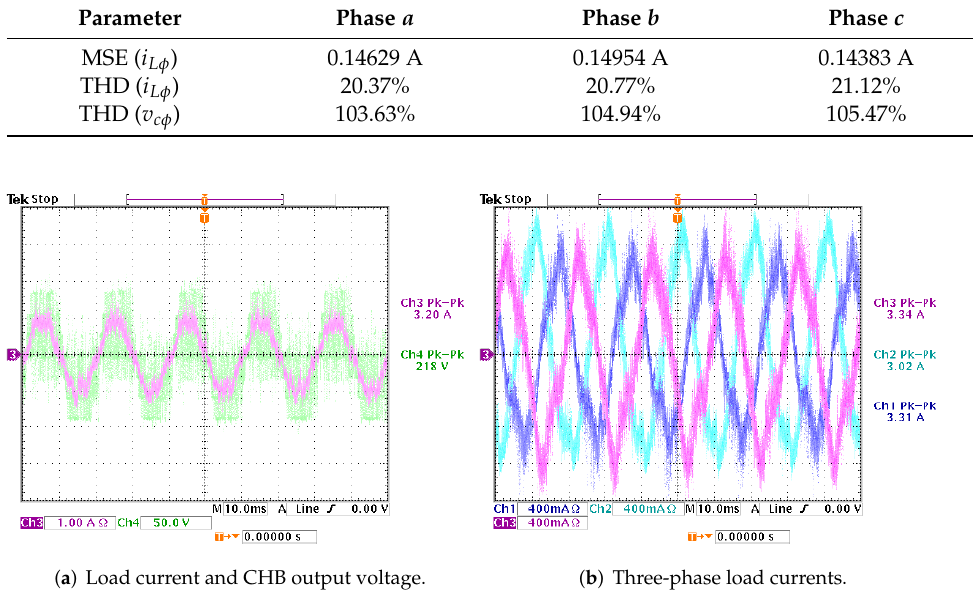
Figure 11. Load currents and CHB output voltage in the presence of parametric